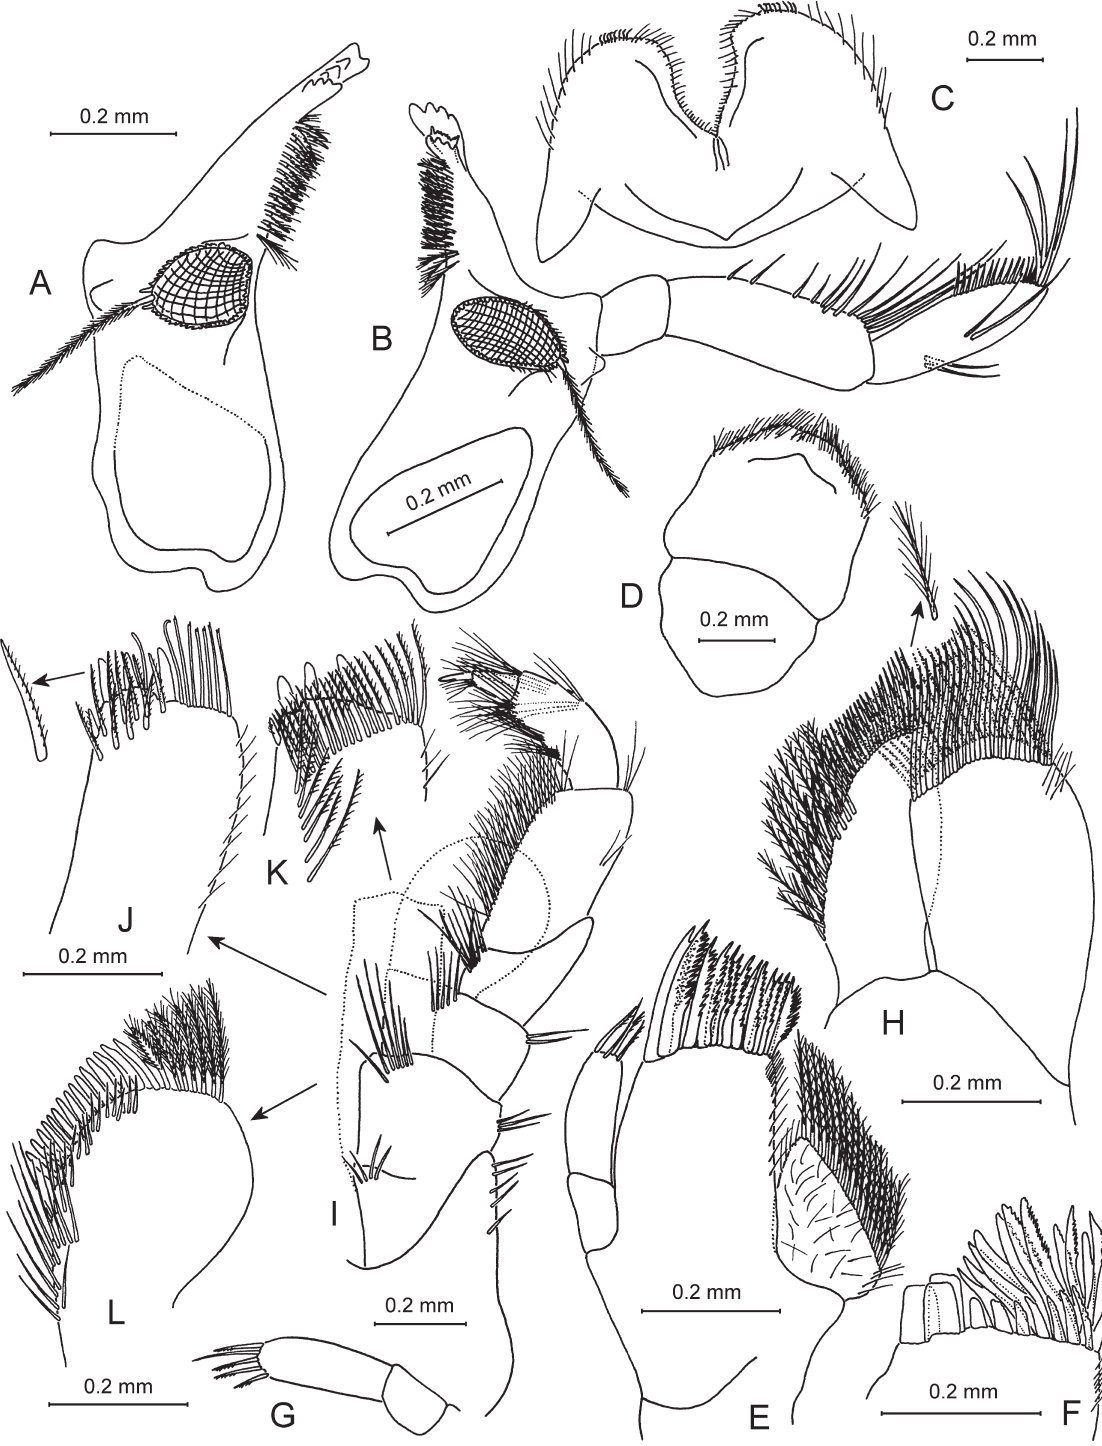
Fig. 8. Zenkevitchia sandroruffoi sp. nov. — A–E , G–K . Holotype, ♂, 8.0 mm, X44041/Cr-1647-FEFU. A . Left mandible. B . Right mandible. C . Lower lip. D . Upper lip. E . Maxilla 1. G . Palp of right maxilla 1. H . Maxilla 2. I . Maxilliped. J . Inner plate of maxilliped, inner face. K . Inner plate of maxilliped, outer face. — F, L . Paratype, ♀, 8.3 mm, X44043/Cr-1649-FEFU. F . Outer plate of maxilla 1. L . Outer plate of